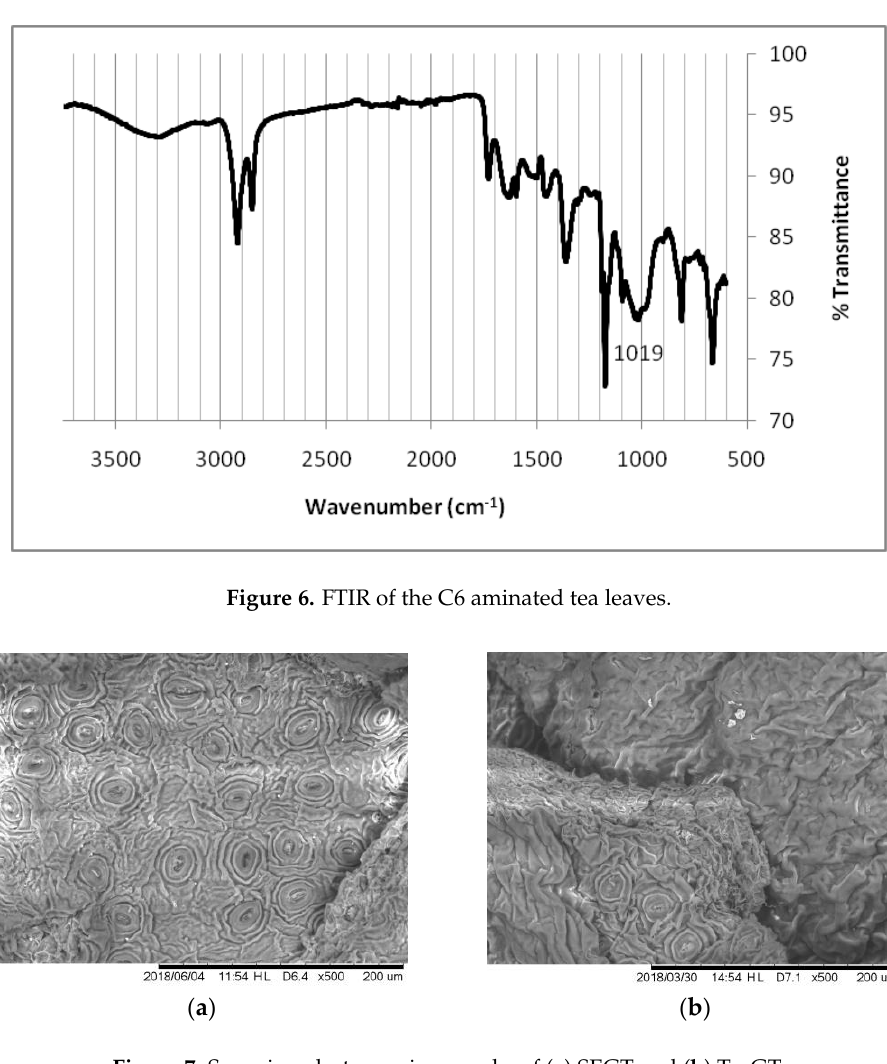
Figure 7. Scanning electron micrographs of ( a ) SEGT and ( b ) TosGT.